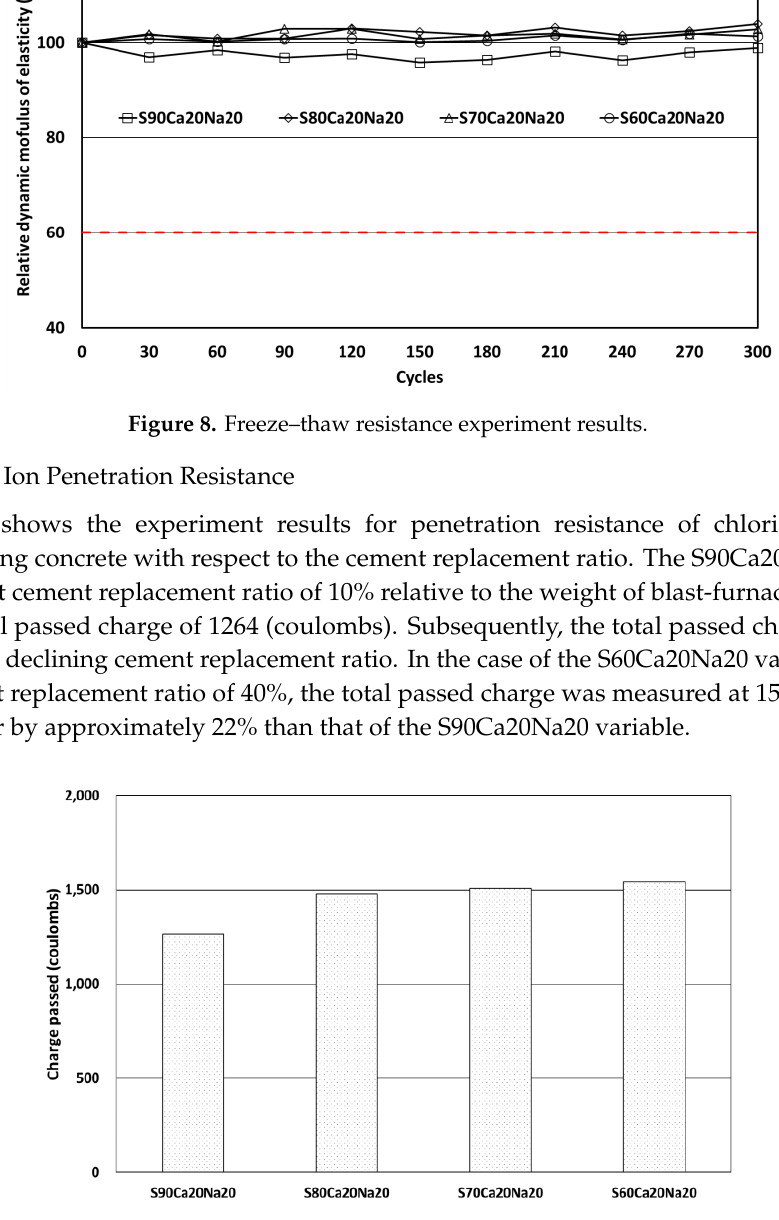
. Figure 10. Image analysis experiment results. The spacing factor and specific surface area of the voids of the concrete after curing are factors for forming good air-void structure of concrete. Sidney Mindess [20] reported that the spacing factor of concrete after curing must be 200 ㎛ (0.2 mm) or lower and the specific surface area 25 mm 2 /mm 3 or higher to secure sufficient freeze–thaw resistance [20]. Therefore, the freeze–thaw resistance of the carbon-capturing concrete with respect to the cement replacement ratio is considered to be excellent based on the measured spacing factor and specific surface area.